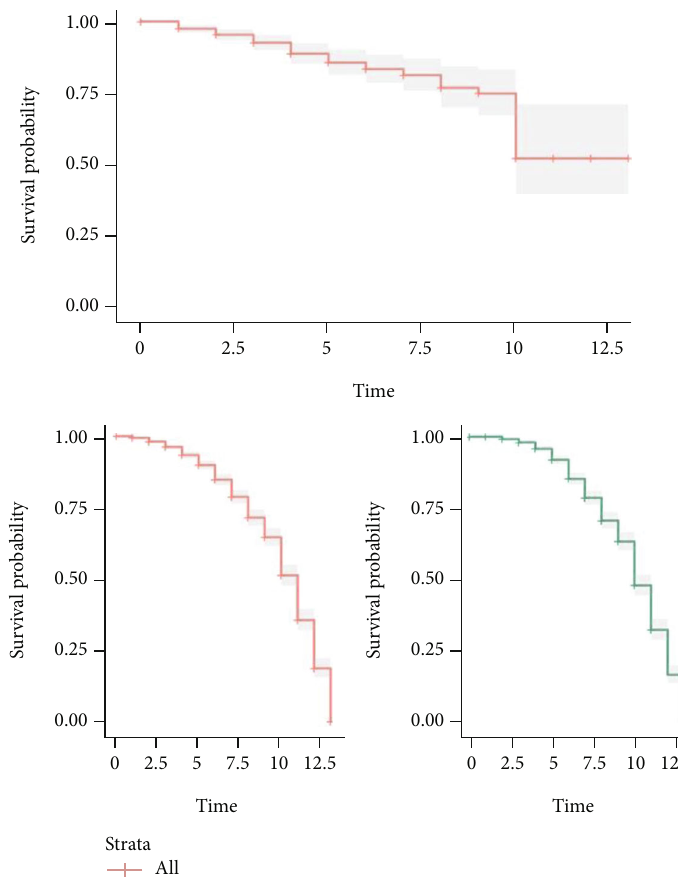
Figure 3: Hospital whole population survival